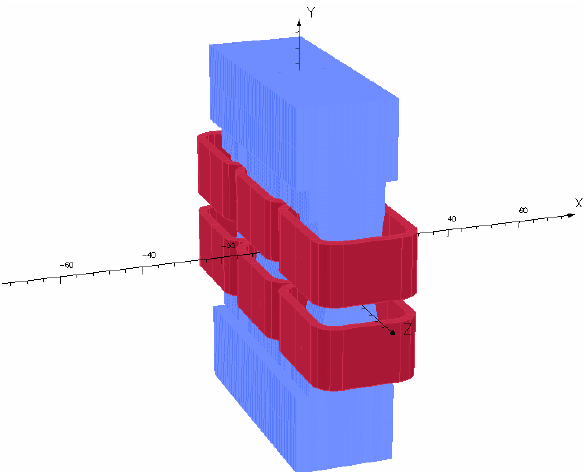
FIG. 11. (Color) Short model of the wiggler. Dimensions are in cm.